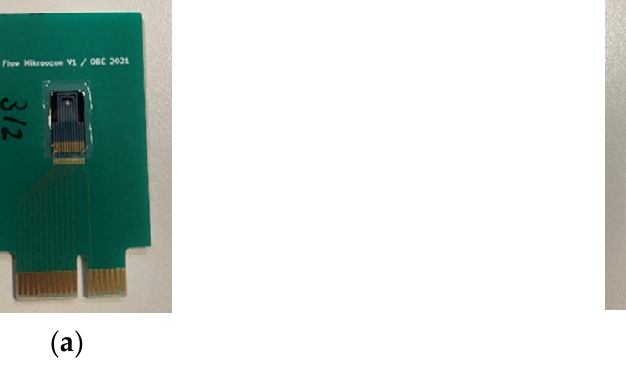
Figure 6. Sensor mounted on custom PCB: ( a ) top-view showing the sensor and card-edge connector and ( b ) bottom-view showing the hole below the PowderMEMS-modified backside cavity.